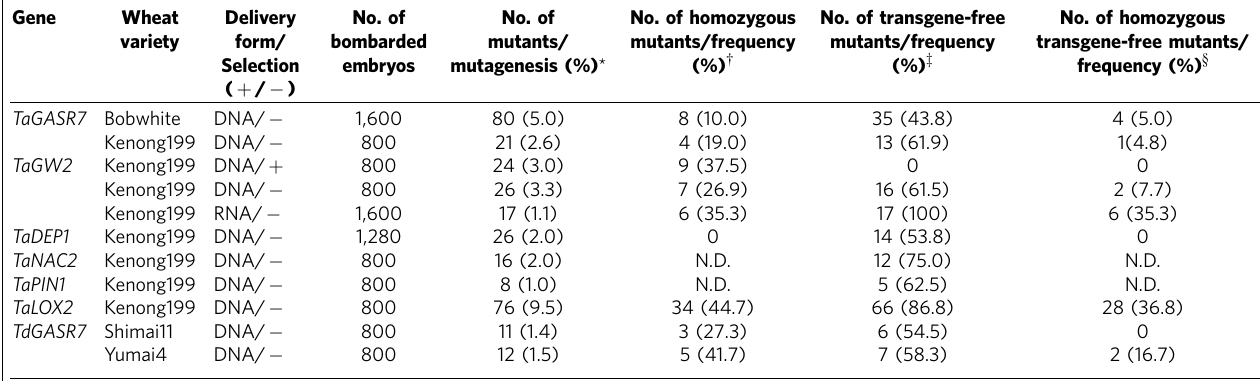
CRISPR, clustered regularly interspaced short palindromic repeat; N.D., not detected. *On the basis of the number of plants carrying the observed mutations over the total number of bombarded immature embryos. w On the basis of the number of plants carrying mutations on all the six alleles over the total number of mutant plants. z On the basis of the number of mutant plants not harbouring CRISPR DNA construct over the total number of mutant plants tested. y OnthebasisofthenumberofplantscarryingmutationsonallthesixallelesandnotharbouringCRISPRDNAconstructoverthetotalnumberofmutantplants.‘ þ ’withherbicideselection;‘ (cid:2) ’without herbicide